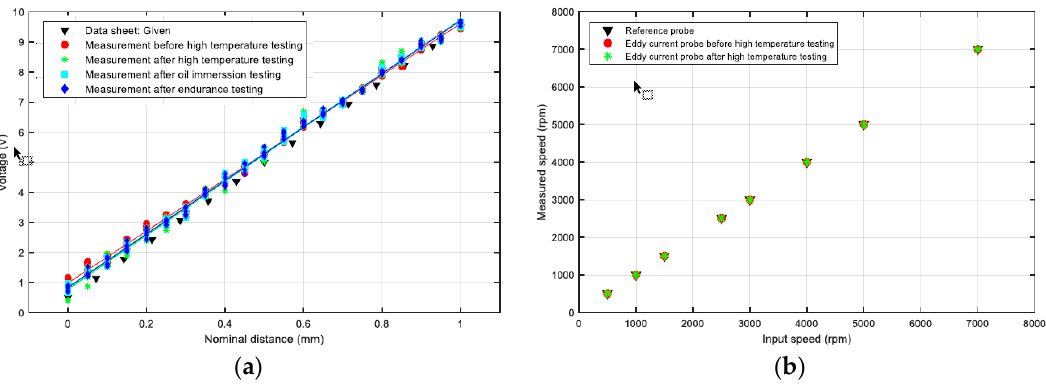
Figure 5. ( a ) Displacement testing to measure the calibration curve of the eddy current probe before and after placing in harsh environmental conditions. ( b ) Speed testing to measure the performance of the probe before and after high temperature testing with respect to reference